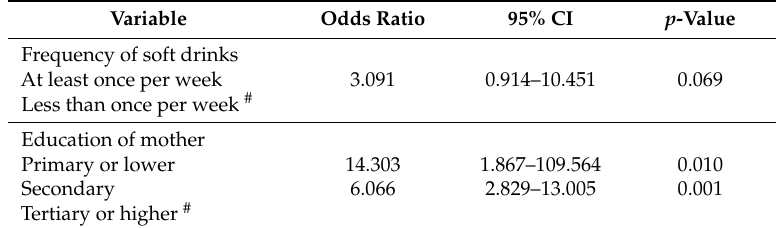
Table 6. Results of logistic regression of the association between erosive tooth wear and explanatory variables among children in Jakarta ( n =